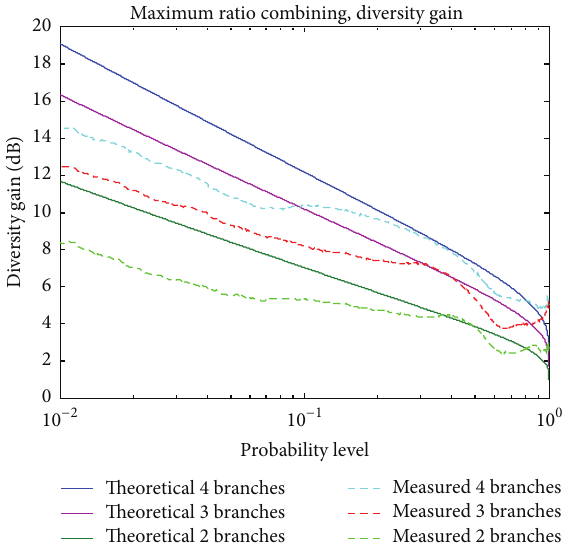
Figure 7: Comparison of diversity gains for two different areas— elevation angle 4.28 ∘